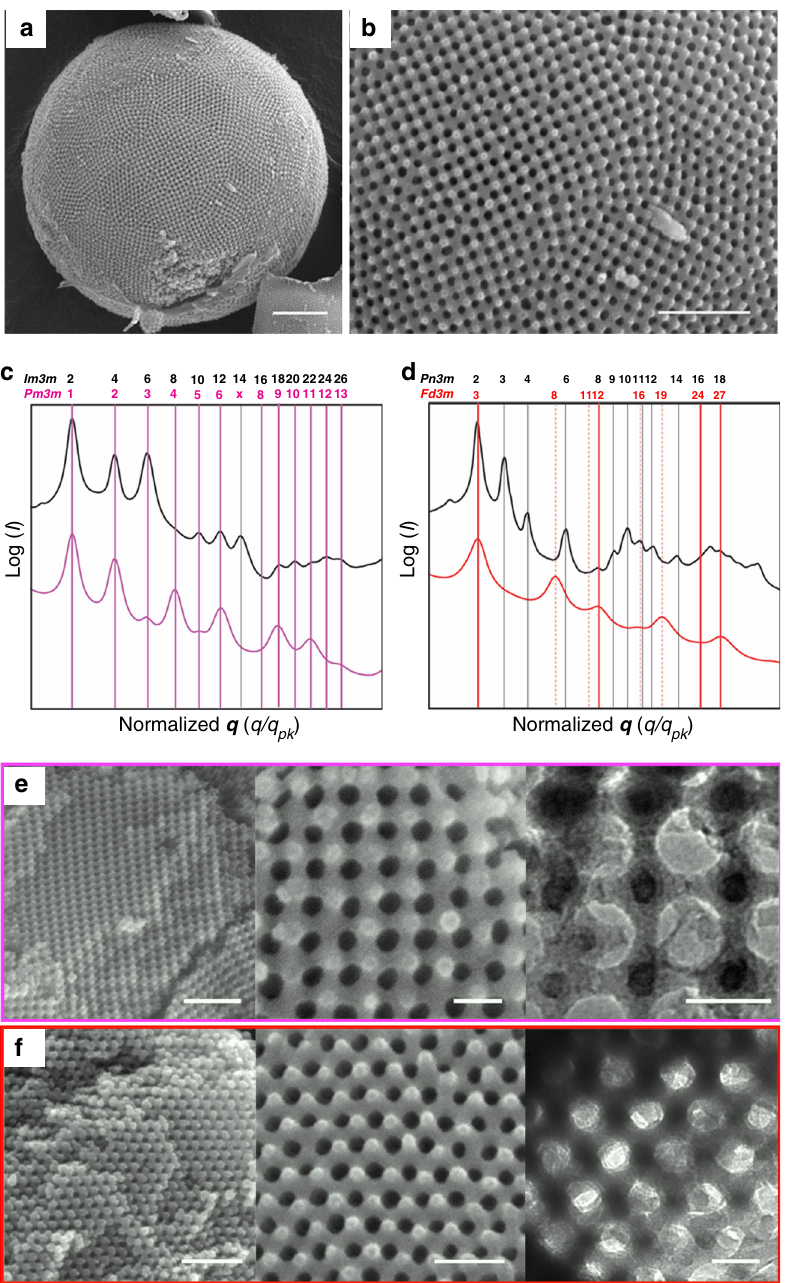
Fig. 3 Structural characterization of silica single networks templated by PCs. a , b SEM images of the silica replica templated by PCs of PEG550 3 -PS 150 showing spherical morphology ( a ) and porous surface ( b ). Scale bars are 1 μ m ( a ) and 500 nm ( b ). c , d SAXS results of skeletal silica replica (color lines) synthesized from the PC templates (black lines). The symmetry transition from the corresponding double networks of the PCs ( Im (cid:1) 3 m for c and Pn (cid:1) 3 m for d ) to simple cubic ( Pm (cid:1) 3 m , a = 56.5 nm) ( c ) and single diamond ( Fd (cid:1) 3 m , a = 90.7 nm) ( d ). Vertical lines correspond to the expected Bragg peak positional ratios (magenta and red; common peaks, dashed red; Fd (cid:1) 3 m only, black; PCs only). e , f SEM and TEM images of the single cubic silica network synthesized from the PCs of PEG550 3 -PS 150 ( e ) and the single diamond silica network obtained from the PCs of PEG550 3 -PS 168 templates ( f ). Scale bars are 300 nm (left), 100 nm (middle), and 50 nm